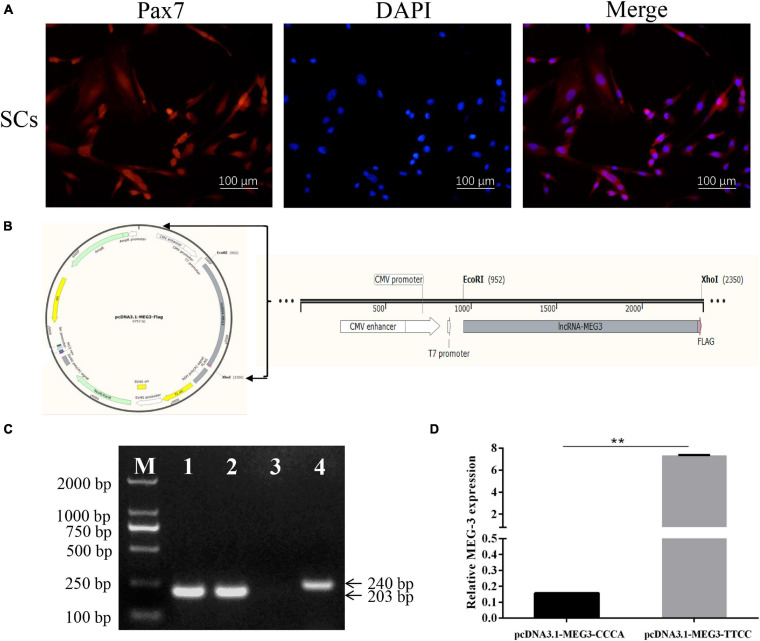
Identification of SCs, construction of the expression vector and the effect of two haplotypes on MEG3 transcription. (A) SCs were identified by immunolabeling with anti-Pax7 (red) monolyclonal antibody; Nuclear are counterstained with DAPI (blue); Merged images represented overlays of Pax7 (red) and nuclear staining by DAPI (blue). (B) A FLAG tag sequence (pink) was added at the 3′ end of the MEG3 sequence (gray). This fragment was inserted into the pcDNA3.1(+) vector between the EcoR I and Xho I site. (C) The RT-PCR results of SCs transfected with pcDNA3.1-MEG3-CCCA, pcDNA3.1-MEG3-TTCC and pcDNA 3.1 (+) vector for 48 h. M: Marker 2000, Line 1–3: the RT-PCR results of pcDNA3.1-MEG3-CCCA group, pcDNA3.1-MEG3-TTCC group and pcDNA 3.1(+) group were amplified by MEG3-FLAG, respectively, Line 4: the RT-PCR results of pcDNA 3.1(+) group were amplified by Primer-GAPDH. (D) The effect of two haplotypes on MEG3 transcription. The significance test: ∗∗P < 0.01.